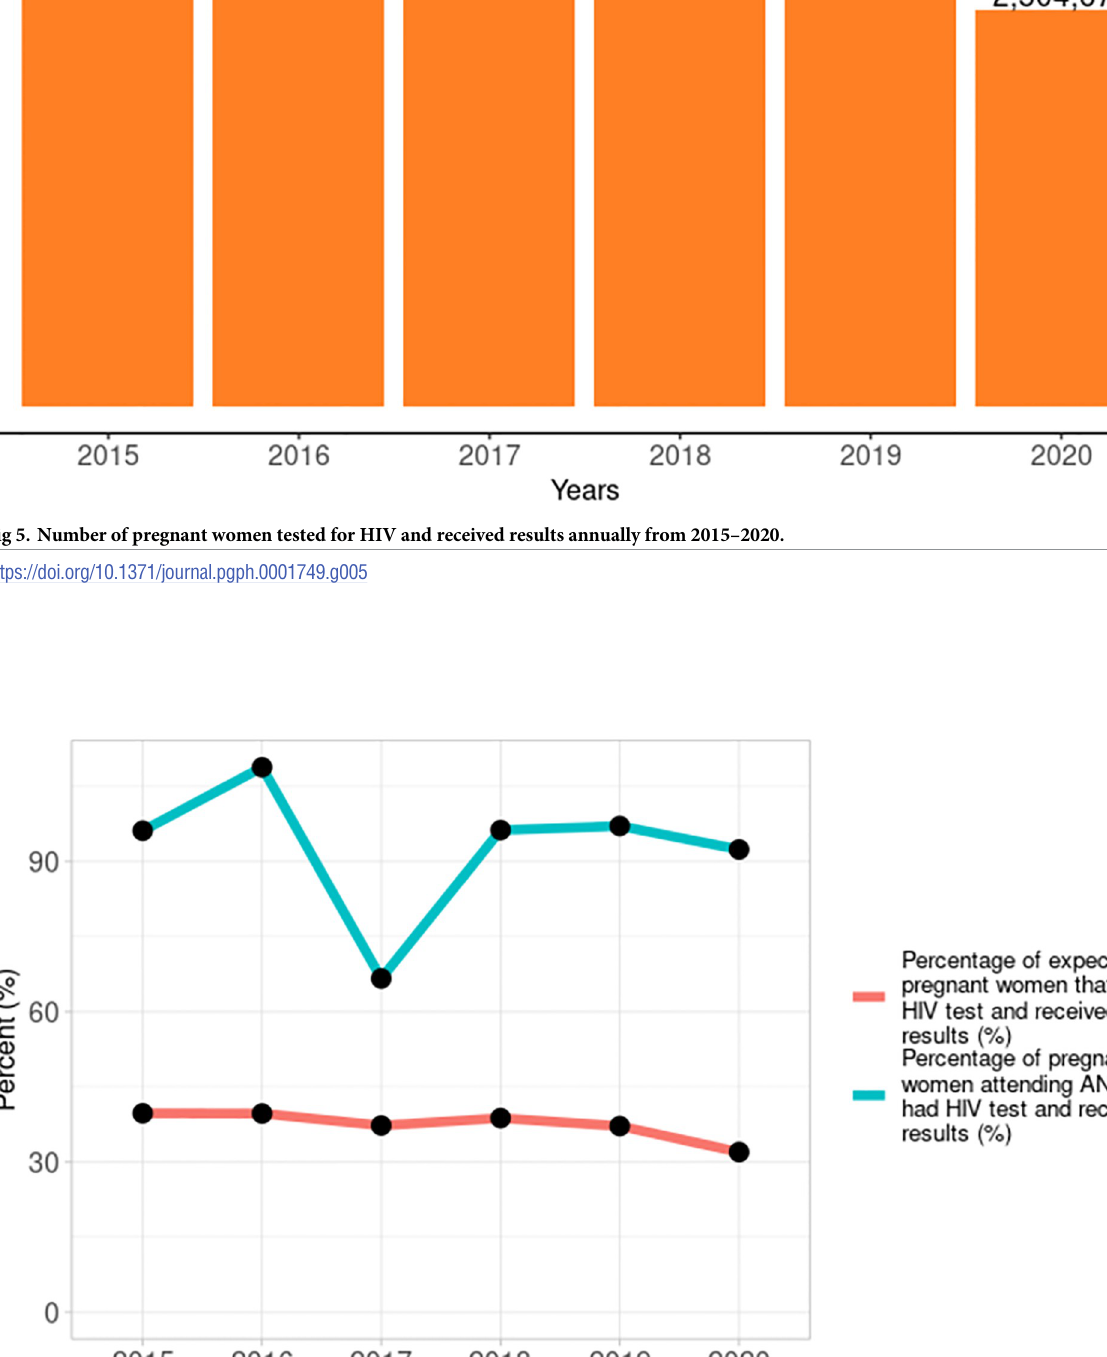
PLOS Global PublicHealth | https://doi.org/10.1371/journal.pgph.0001749 April 4, 2023 8 /